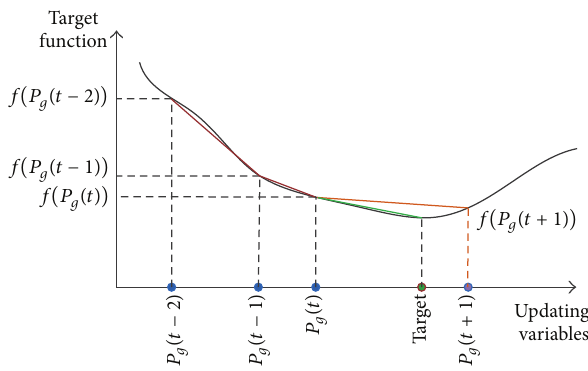
Figure 5: Adaptive state updating of global optimal